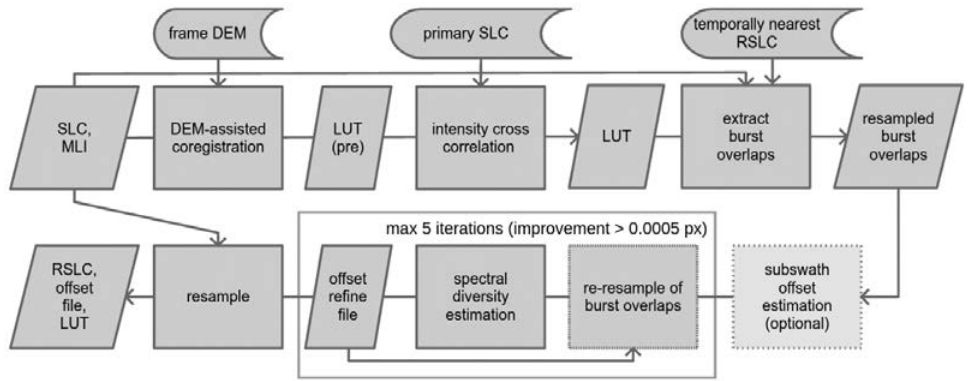
Figure 3. Detailed overview of the coregistration process for a new SLC image (generation of RSLC and complementary files).